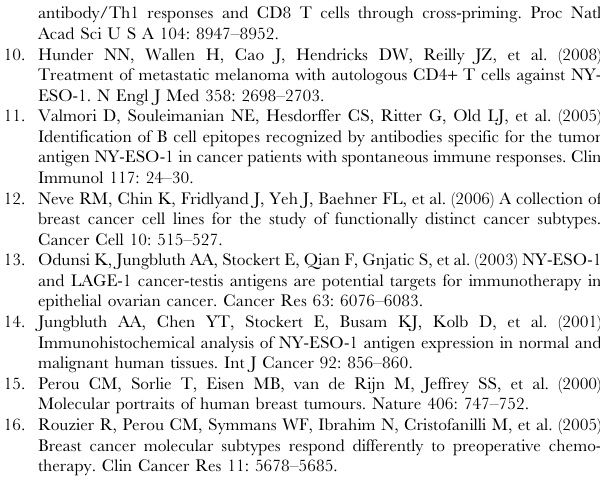
Figure S1 Assessment of ESO expression in normal tissues. ESO expression was assessed by semi-quantitative PCR ( A ) and qPCR ( B ) following reverse transcription of mRNA from a panel of normal tissues and was used to determine the cut-off between positive and negative tumor samples. (TIF) Figure S2 Expression of ESO and of basal-like carcino- ma associated markers in triple negative BC. Expression of ESO, CK5, CK14, EGFR and p63 was assessed by IHC staining of paraffin-embedded tumors from a cohort of 42 patients with triple negative BC (Supporting Table S1). The percentage of tumors expressing ESO within the entire cohort and of tumors expressing the indicated basal-like associated markers within the entire cohort or among ESO + tumors are shown. na, non applicable. Table S1 Expression of ESO and of basal-like carcino- ma associated markers in a cohort of triple negative breast